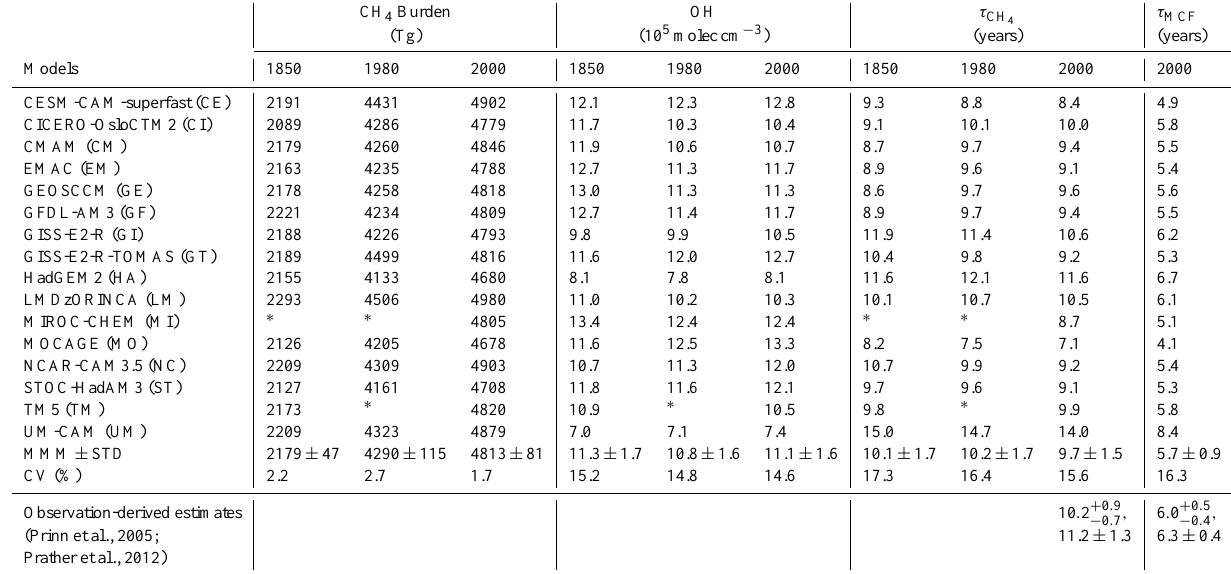
Table 1. Global total methane burden, airmass-weighted tropospheric mean OH, and tropospheric methane lifetime ( τ CH and 2000 time-slices, and tropospheric CH 3 CCl 3 lifetime ( τ MCF ) for 2000 time-slice from 16 models. The troposphere is assumed to extend from surface to 200hPa for each model’s grid. A cell with ∗ means that the model did not report that quantity. Multi-model mean (MMM) with standard deviation (STD), coefficient of variation (CV; standard deviation as percentage of the multi-model mean), and observation-derived estimates of τ CH and τ MCF (based on Prinn et al. (2005) and Prather et al.(2012)) are shown in the last three 4